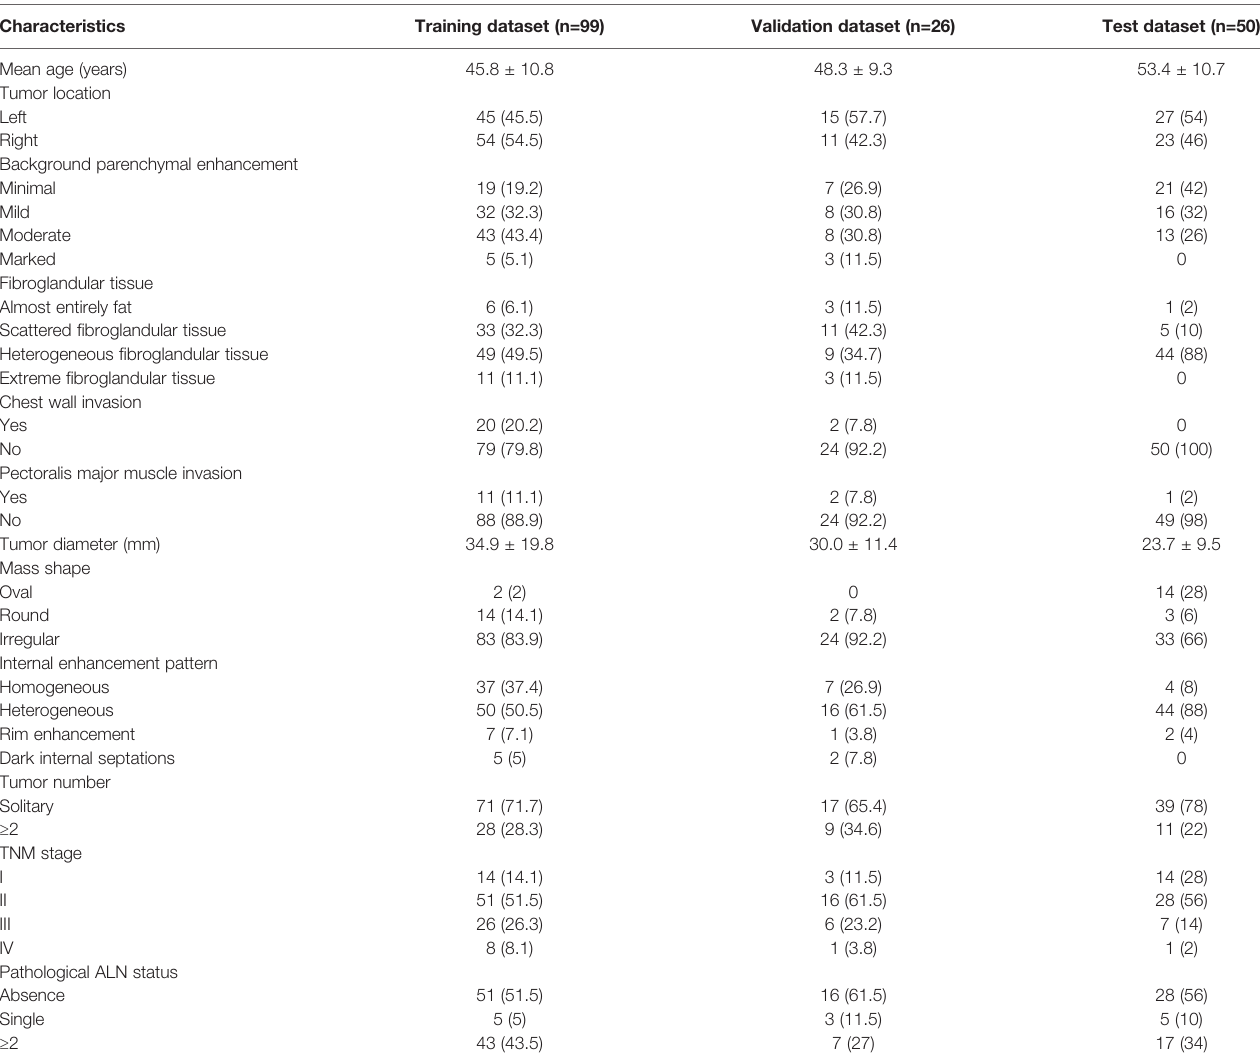
TABLE 1 | Demographic and clinical characteristics of patients.